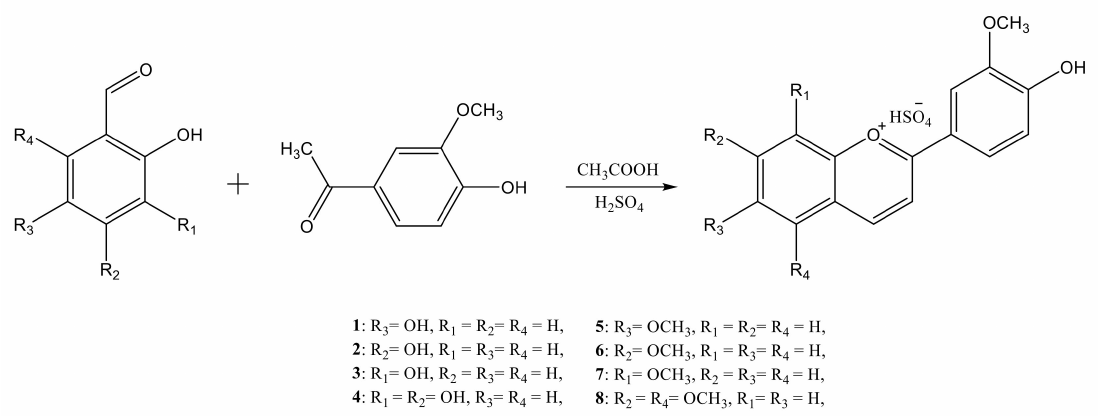
Figure 1. Reaction scheme for the synthesis of the synthetic